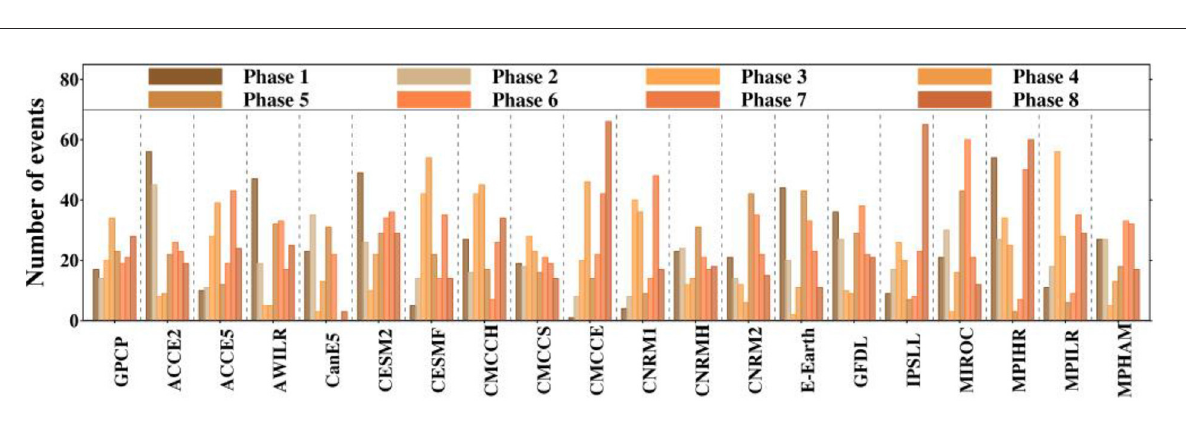
FIGURE6 Number of days of dry extreme rainfall events for active BSISO